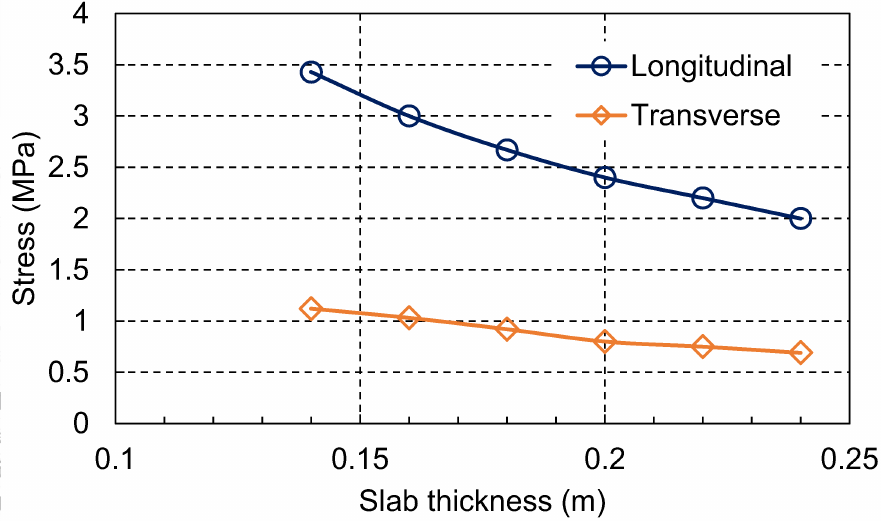
Figure 3. The effect of concrete slab thickness on the stress